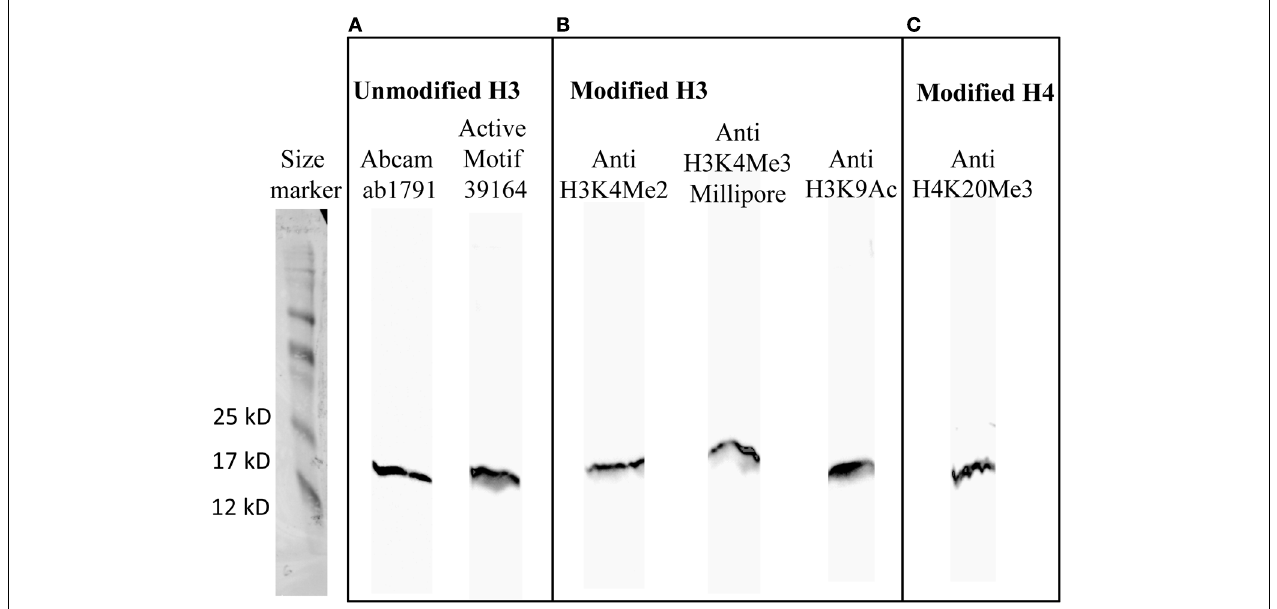
FIGURE 2 | Western blot detection of (A) unmodified histone H3, (B) modified histone H3: dimethylated H3 at lysine 4 (H3K4Me2) and acetylated H3 at lysine 9 (H3K9Ac) and (C) modified histone H4: trimethylated H4 at lysine 20 (H4K20Me3) in M. incognita J2s.